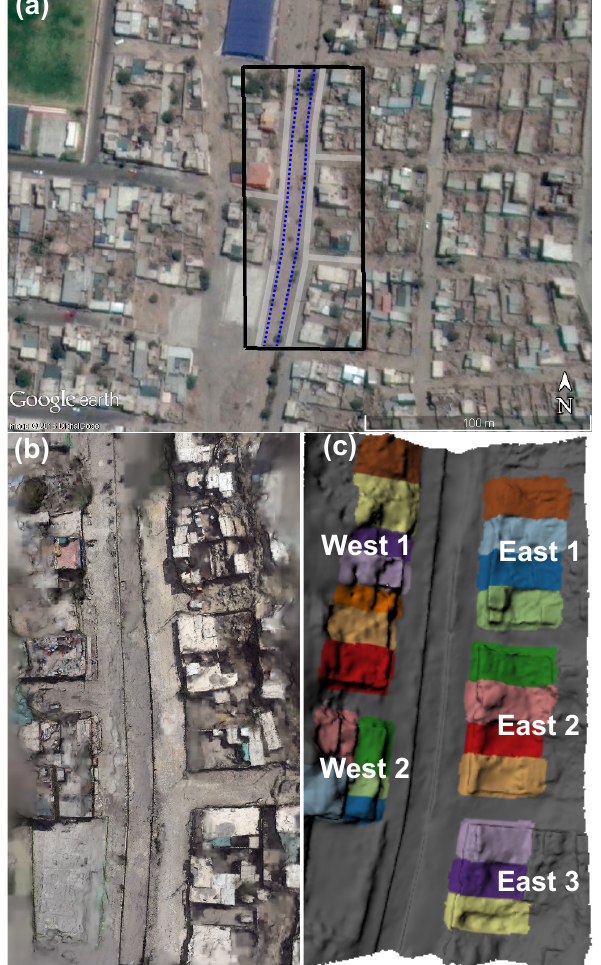
Figure 2. Overview of the Quebrada Dahlia study area, Are- quipa, (a) aerial image with black outline showing study area, dashed outline showing channel banks and transparent lines show- ing streets in the area, (b) photogrammetric reconstruction of the surface and (c) individual buildings and building blocks identified from building surveys.